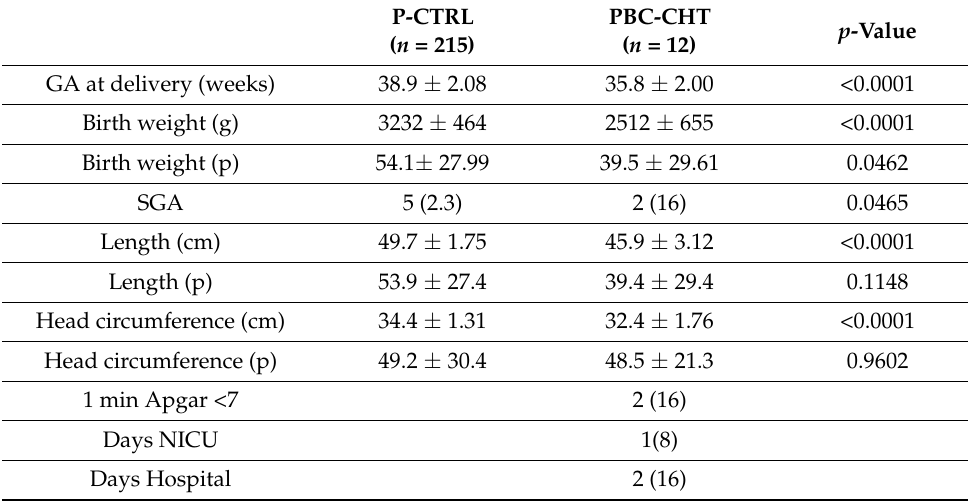
Table 2. Perinatal outcome of study